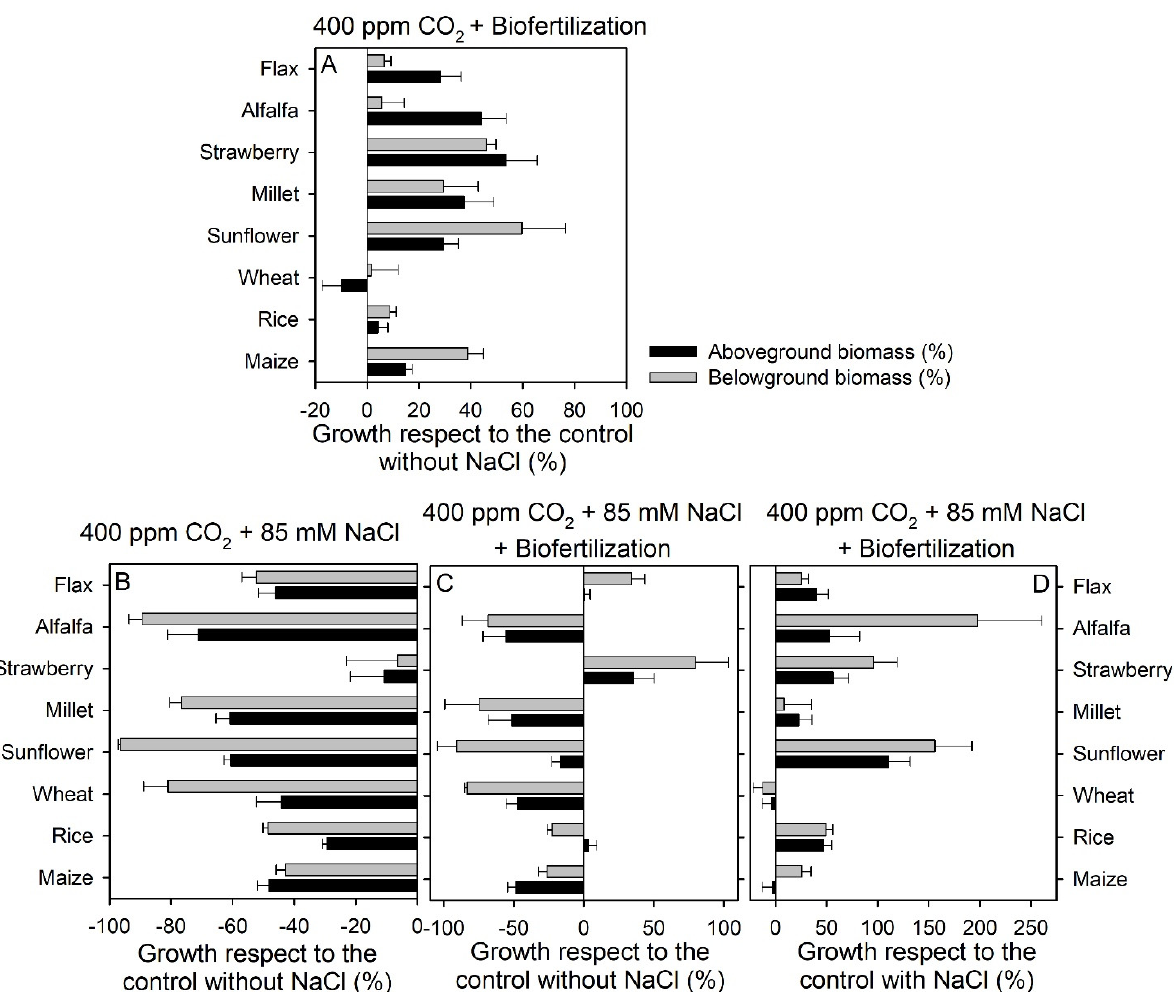
Figure 2. Effect of the most suitable biofertilizer for each crop on its growth at 400 ppm CO 2 . ( A ) Percentage change in above ‐ and below ‐ ground biomass production of biofertilized crops with respect to non ‐ inoculated controls. ( B ) Percentage change in above ‐ and below ‐ ground biomass production of non ‐ inoculated and ( C ) inoculated crops, grown with 85 mM NaCl, with respect to non ‐ inoculated controls grown both without and ( D ) with NaCl. Each value represents the mean of ten replicates (twenty for rice) ± SE. Note: the label in the upper part of the graph indicates the treatment that is presented and the label in the lower part indicates with respect to which control treatment the percentage change of biomass was calculated.